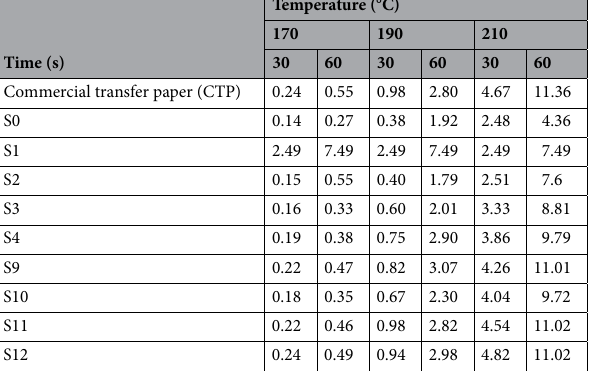
Table 6. The K/S of transfer printed polyester fabrics using different modified screen-printed papers at different transfer conditions.